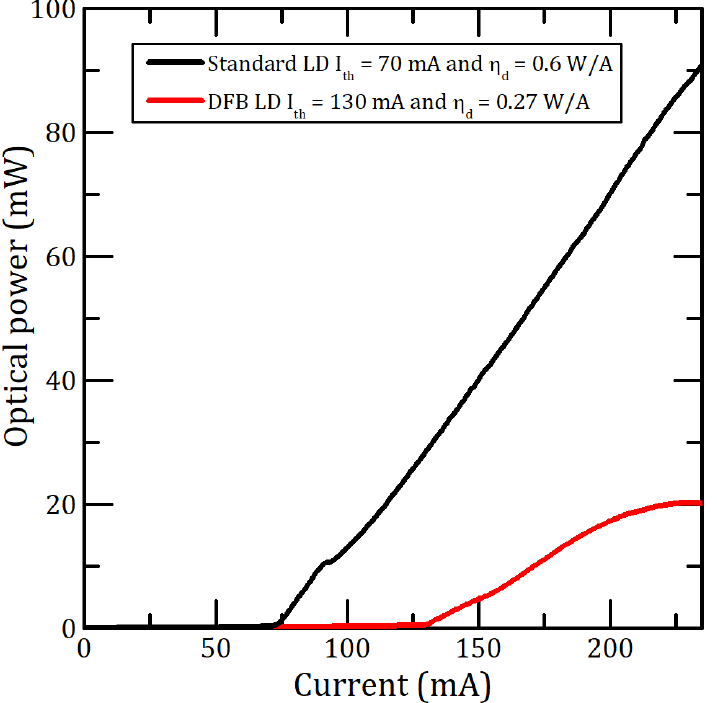
Figure 9. Comparison of the LI characteristics between a standard FP LD (black) and a 39th-order DFB GaN LD (red).